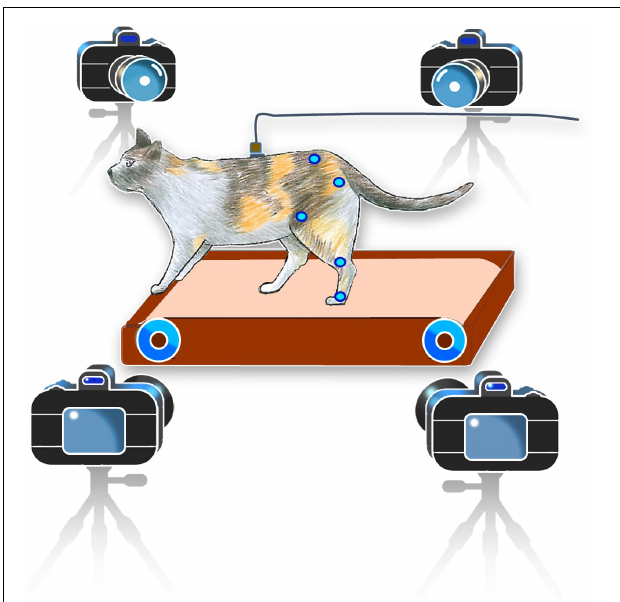
FIGURE 2 | Schematic representation of the experimental setup. Cats were trained to walk on the treadmill in a hindlimb-only condition while keeping their forelimbs on the front frame of the treadmill for balance. Kinematics information was recorded using a motion capture system. Neural signals were recorded during walking on a treadmill and converted from analog to digital using a data acquisition system and were then used to decode the joint angles in a desktop computer.